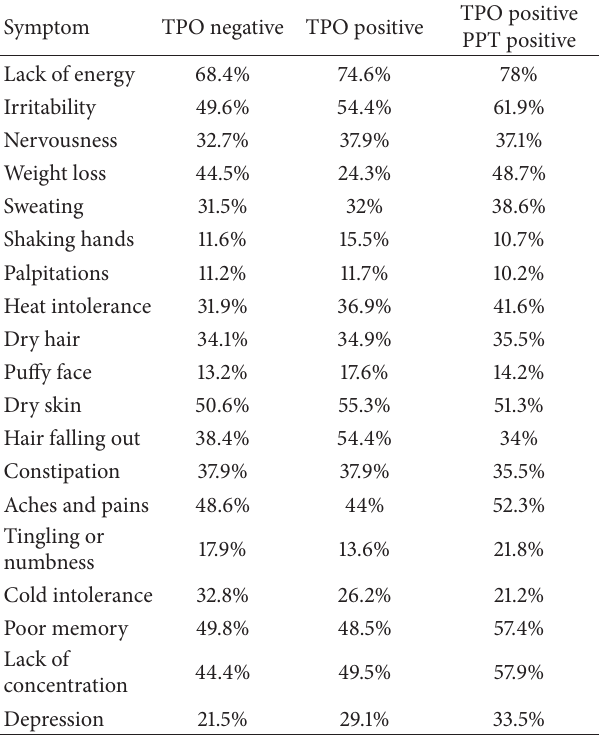
Figure 2: (a) Hypothyroid subscale scores by group. Error bars are standard errors of the mean. (b) Hyperthyroid subscale scores by group. Error bars are standard errors of the mean. Table 3: Percent of women reporting any symptoms on thyroid symptom checklist by TPO and PPT